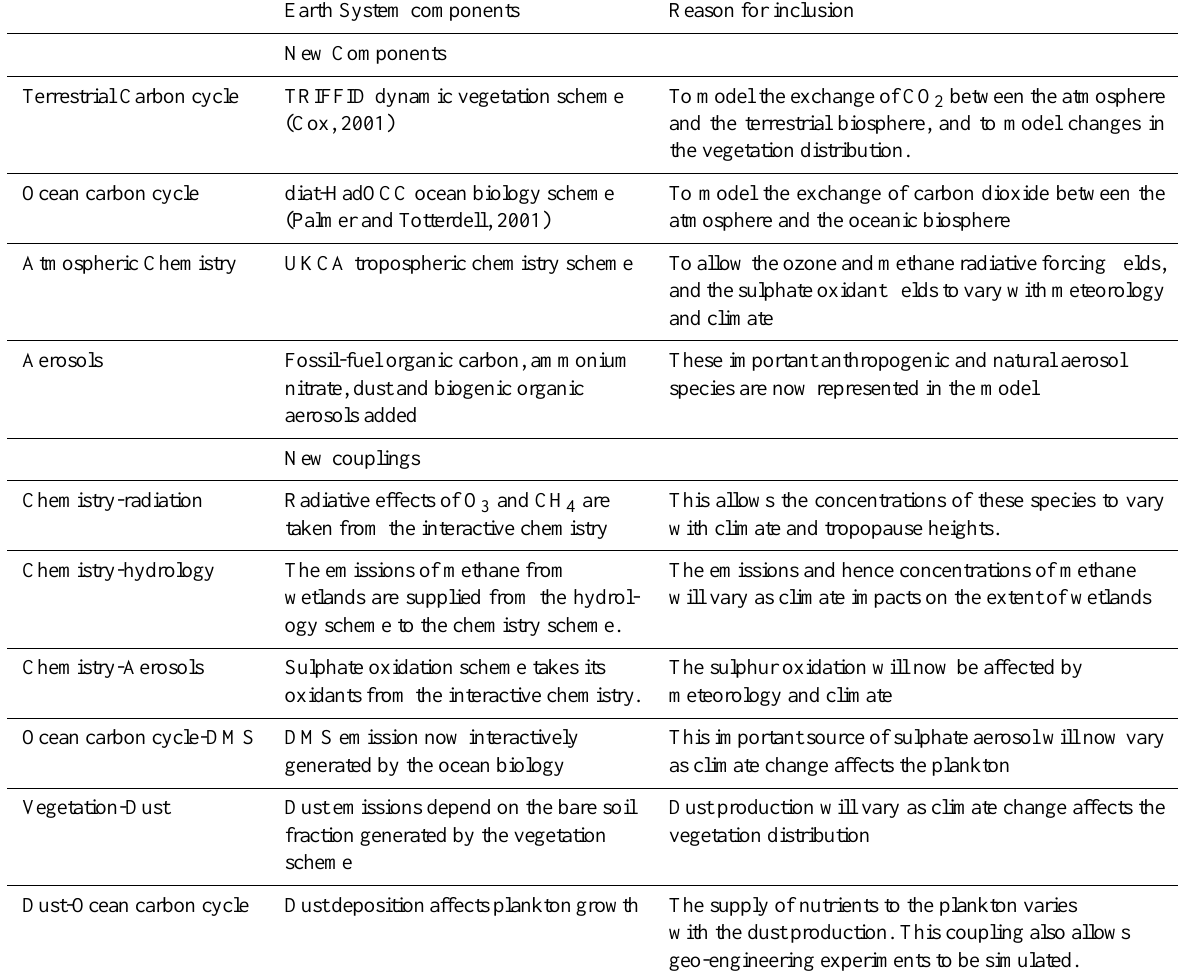
Table 1. Summary of main Earth system additions from HadGEM1 to